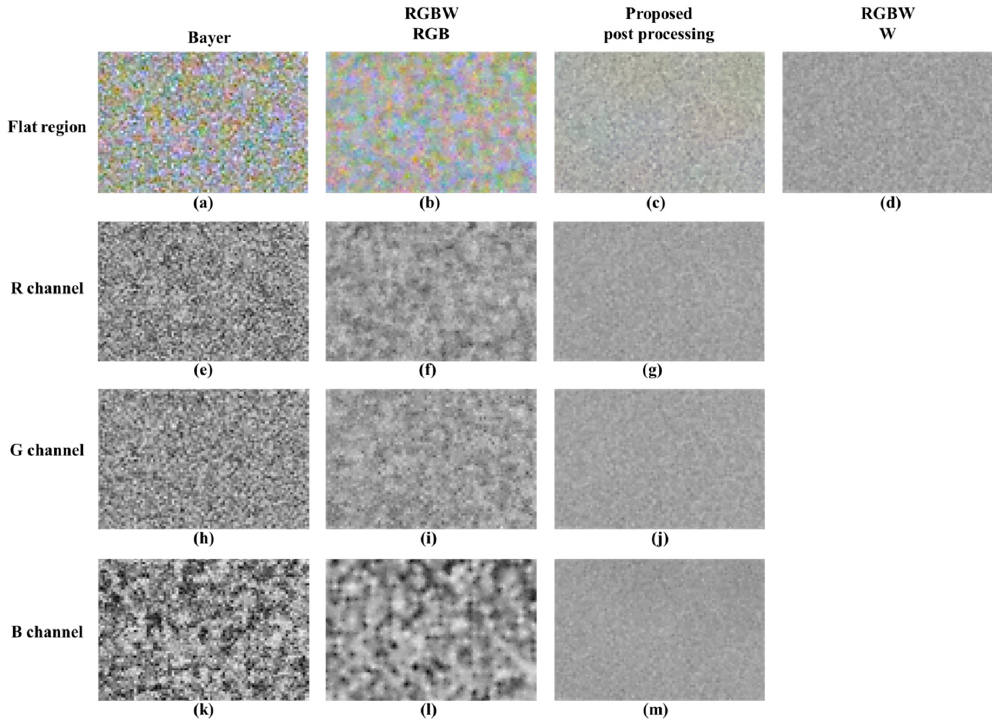
Figure 15. Comparison of luminance / color noise in a flat region: ( a , e , h , k ) Bayer CFA demosaicing results [19]; ( b , f , i , l ) RGB channels of Sony RGBW CFA demosaicing results [24]; ( c , g , j , m ) proposed